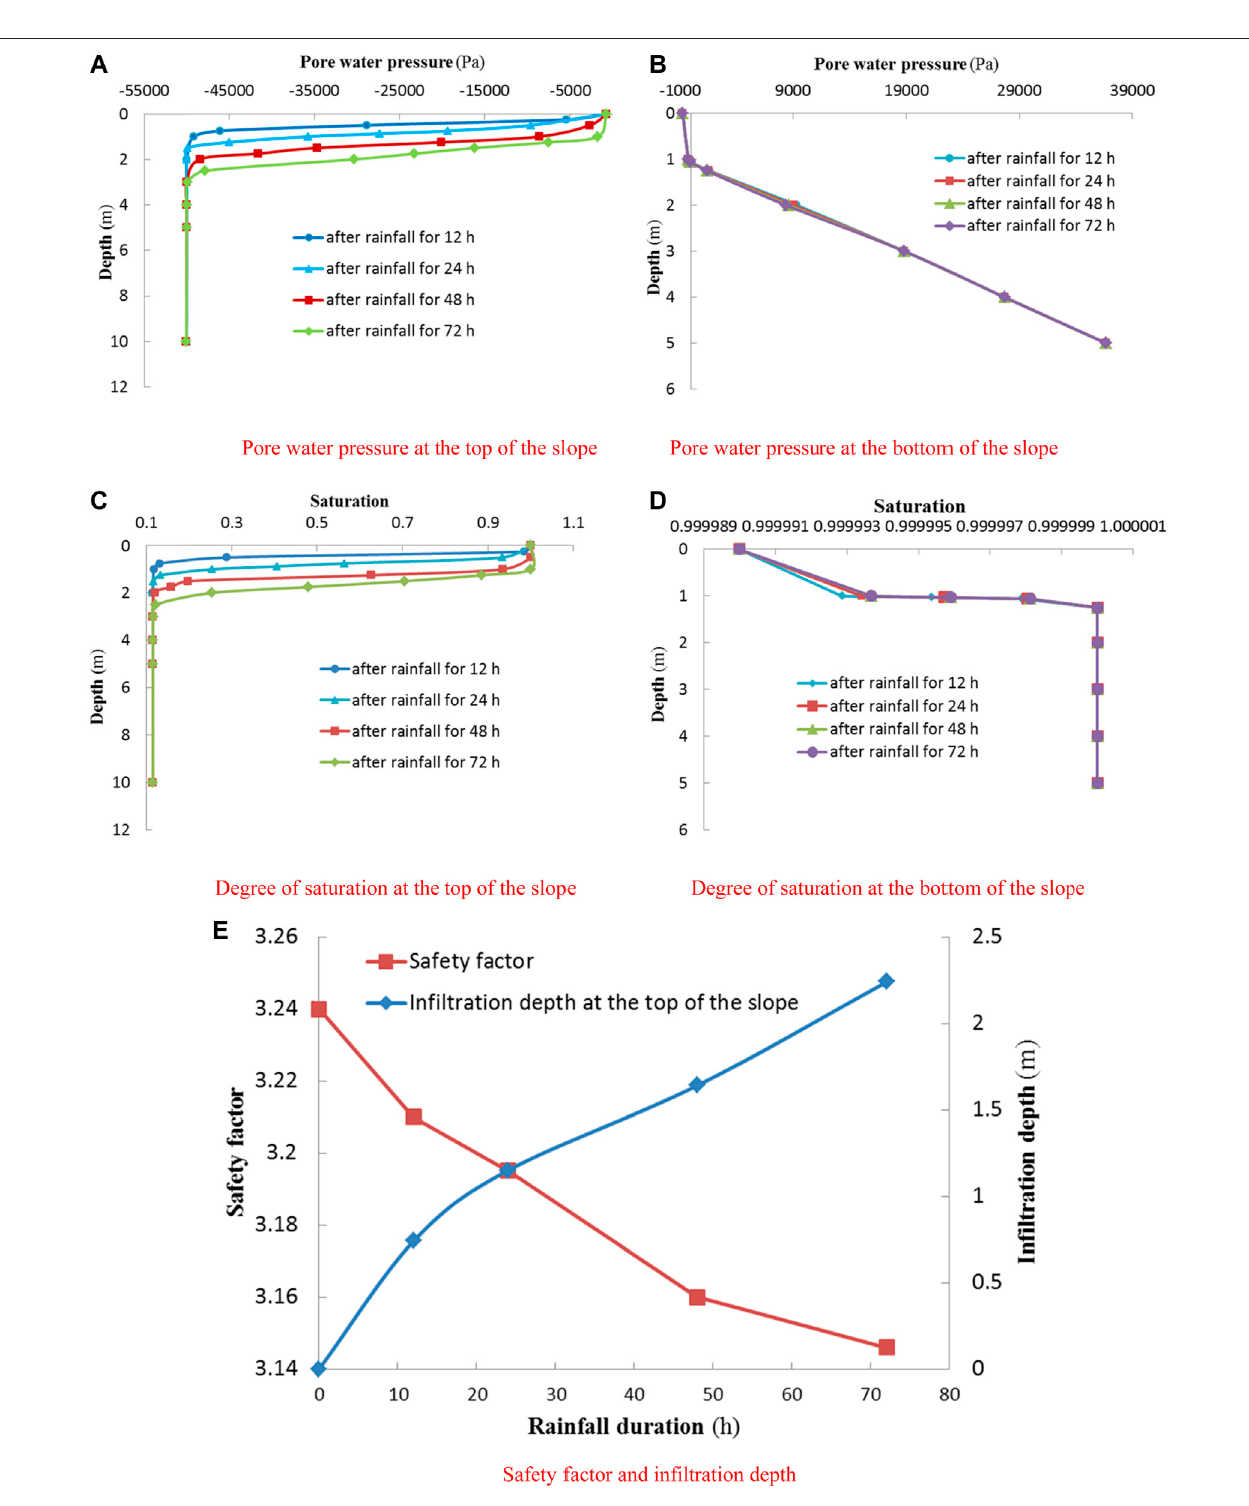
FIGURE8| Theseepageandstabilityoftheslopewiththedevelopmentofrainfallduration: (A) Porewaterpressureatthetopoftheslope, (B) Porewaterpressure at the bottom of the slope, (C) Degree of saturation at the top of the slope, (D) Degree of saturation at the bottom of the slope, (E) Safety factor and in fi ltration depth.